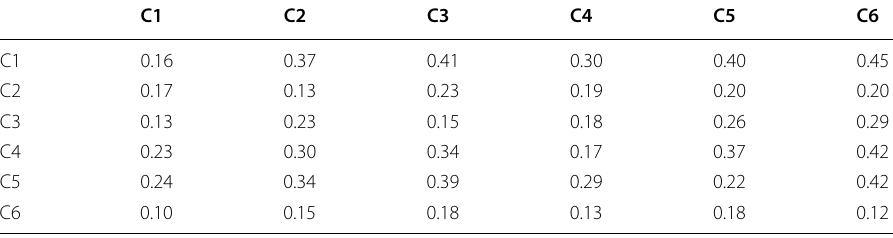
Table 12 Defuzzified total relation matrix. Source : Author’s own